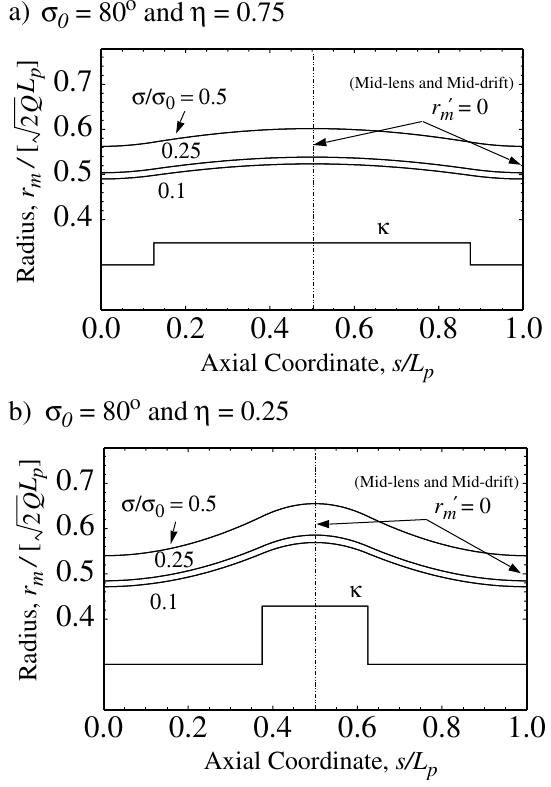
p (cid:4) versus = (cid:3) (cid:1)(cid:1)(cid:1)(cid:1)(cid:1)(cid:1)(cid:1) 2 Q L m p for one period of a hard- p indicated for occu- 0